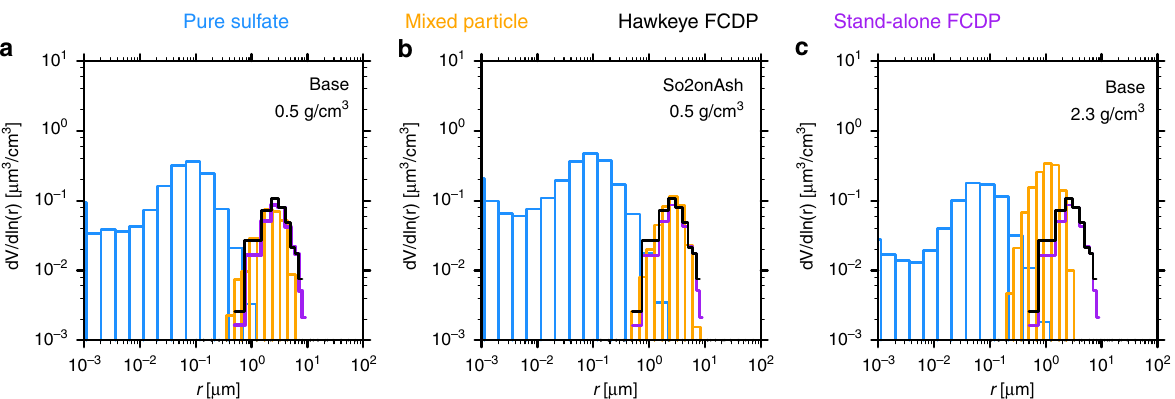
Fig. 4 The particle volume size distributions near Guam. The particle volume size distributions from the simulated pure sulfate (blue), mixed particles (orange) and the two ATTREX FCDP probe observations (black and purple) around 16.5 – 18.5 km near Guam about 25 days after the eruption. No pure ash remains at this time. Panel a is the Base case assuming ash density of 0.5 g/cm 3 ; b the SO2onAsh case assuming ash density of 0.5 g/cm 3 ; c the Base case assuming ash density of 2.3 g/cm 3 details are described in Woods et al. 33 and Jensen et al. 3 . These